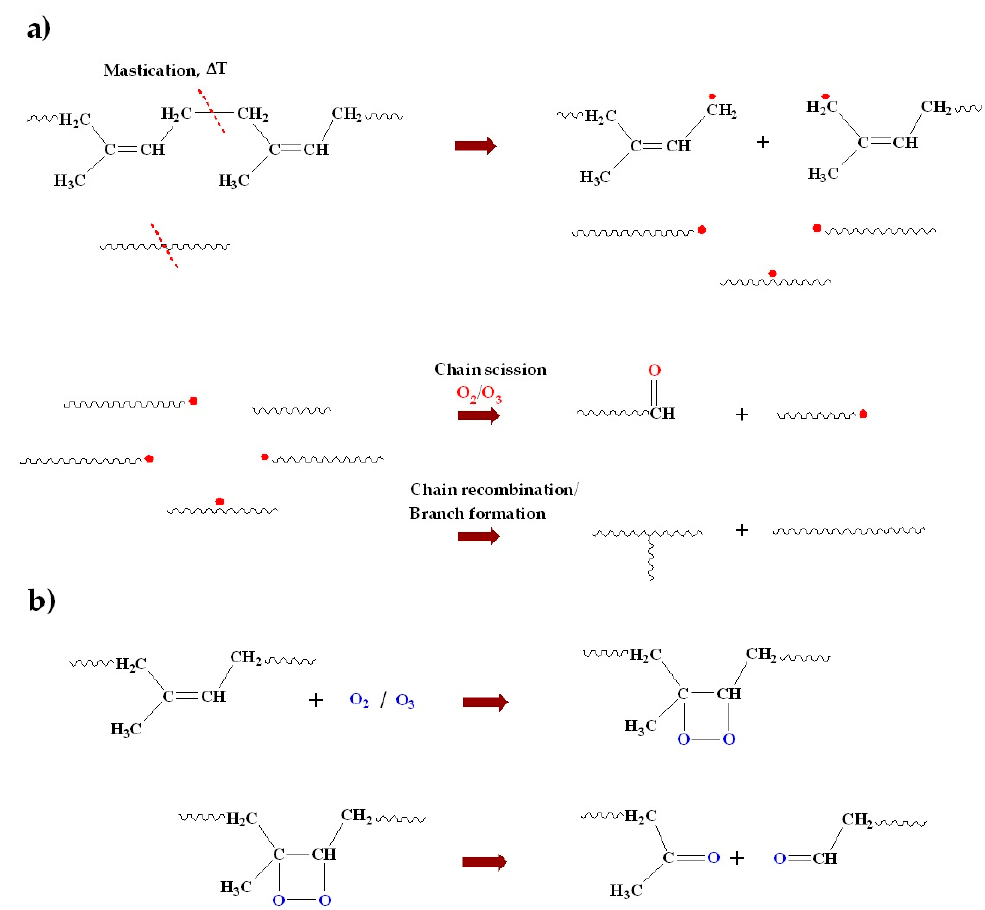
Figure 3. Mechanism of mechanical or thermal degradation ( a ); and oxidative degradation of NR ( b ).